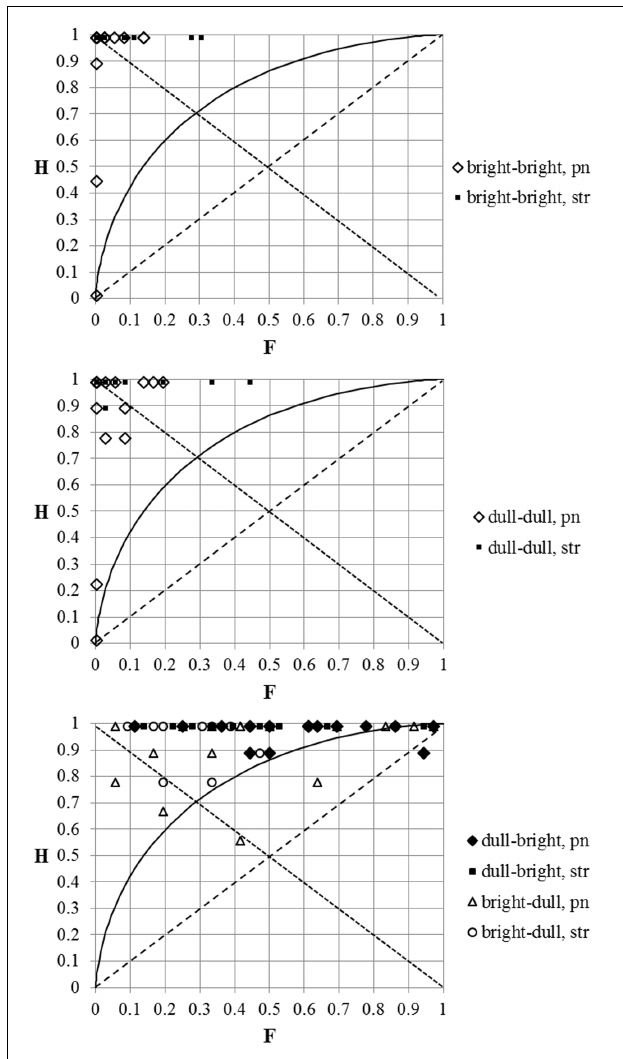
FIGURE 8 | The same as Figure 6, but only the replies to the stimulus-pairs with (cid:2) F 0 = 60 cents and zero cents were included in the analysis.